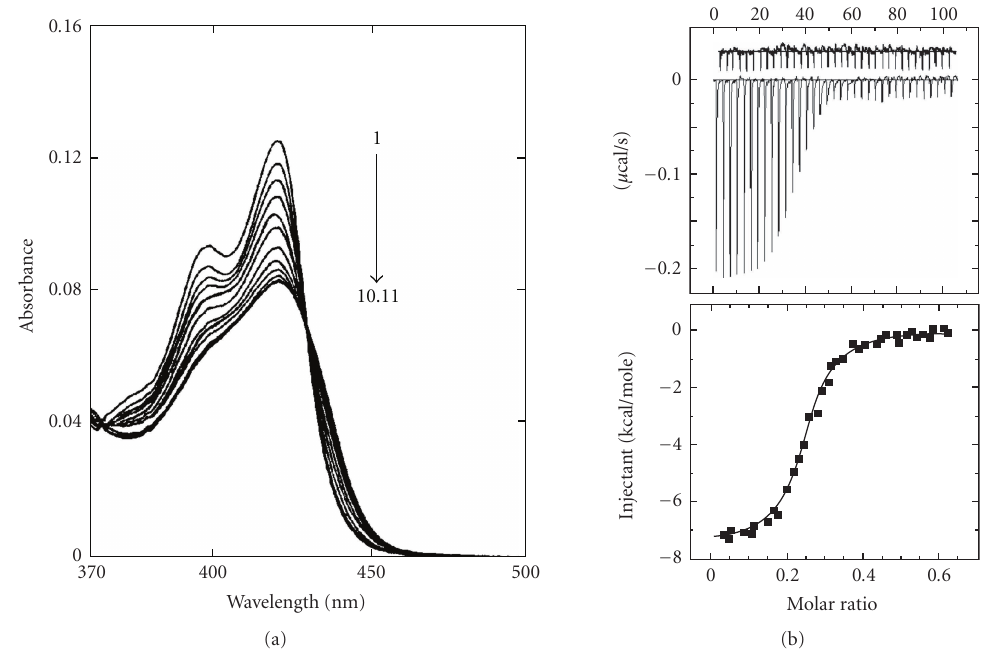
(a) Figure 5: (a) Absorption spectrum (1) of coralyne (7.09 μ M) with increasing concentrations up to 81.73 μ M (10) and 96.28 μ M (11) of calf thymus DNA. (b) The ITC profiles for the titration of calf thymus DNA (65 μ M) to coralyne (15 μ M) at 20 ◦ C. Each heat burst curve in the upper panel is the result of a 5 μ L injection of DNA into coralyne. The lower panel represents the corresponding normalized heat signals versus molar ratio. The data points reflect the experimental injection and the solid line represents the best fit of the data. Reprinted from the Ph.D. Thesis of Bhadra, [28].